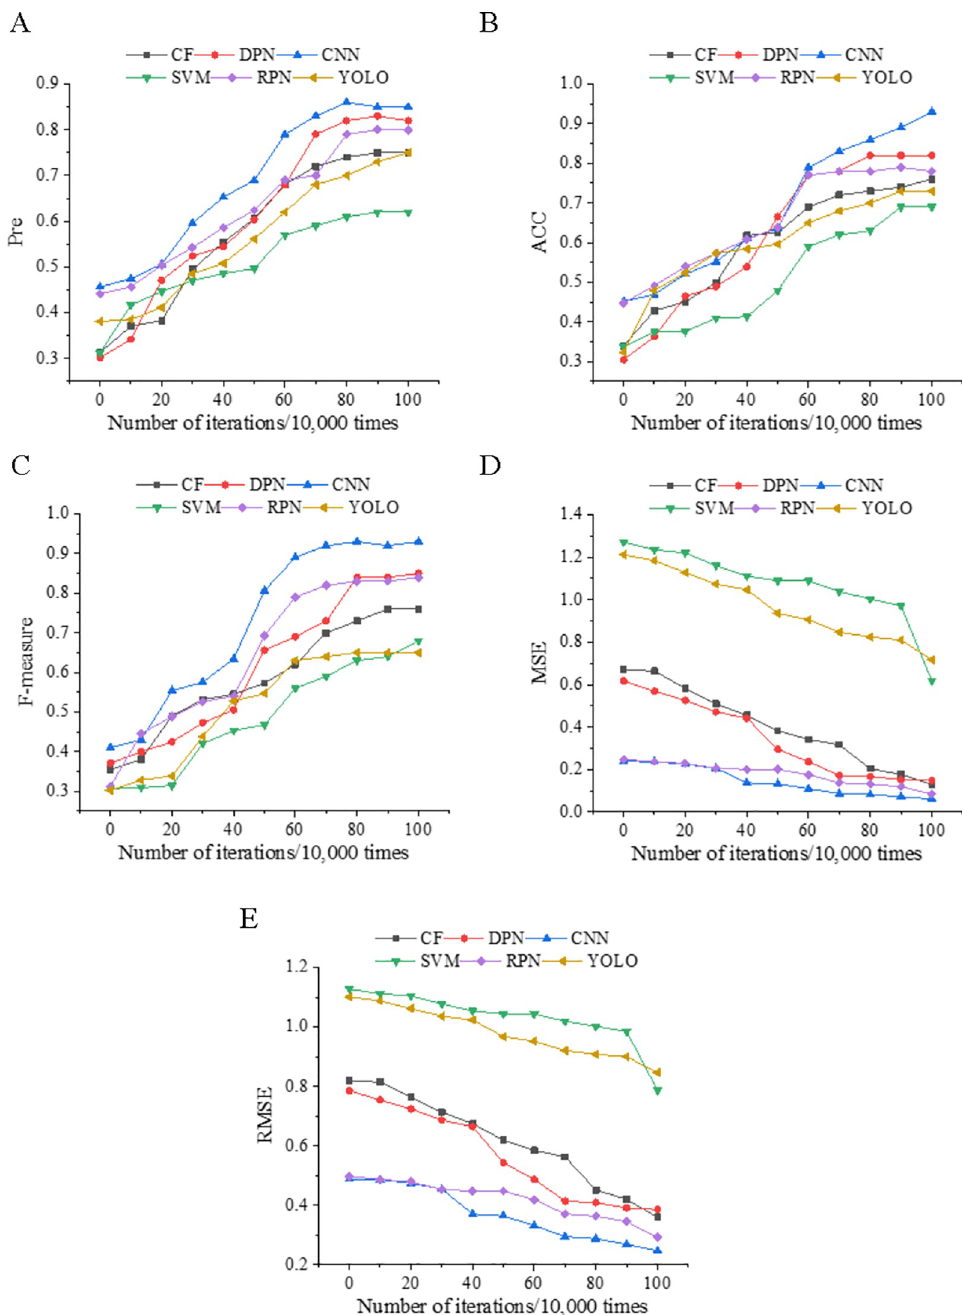
Fig 9. Target tracking results based on CNN. Note: common target tracking algorithms include CF (Collaborative Filtering), DPN (Deformable Parts Model), SVM (Support Vector Machine), RPN (RPN+Fast RCNN), and YOLO (You Only Look